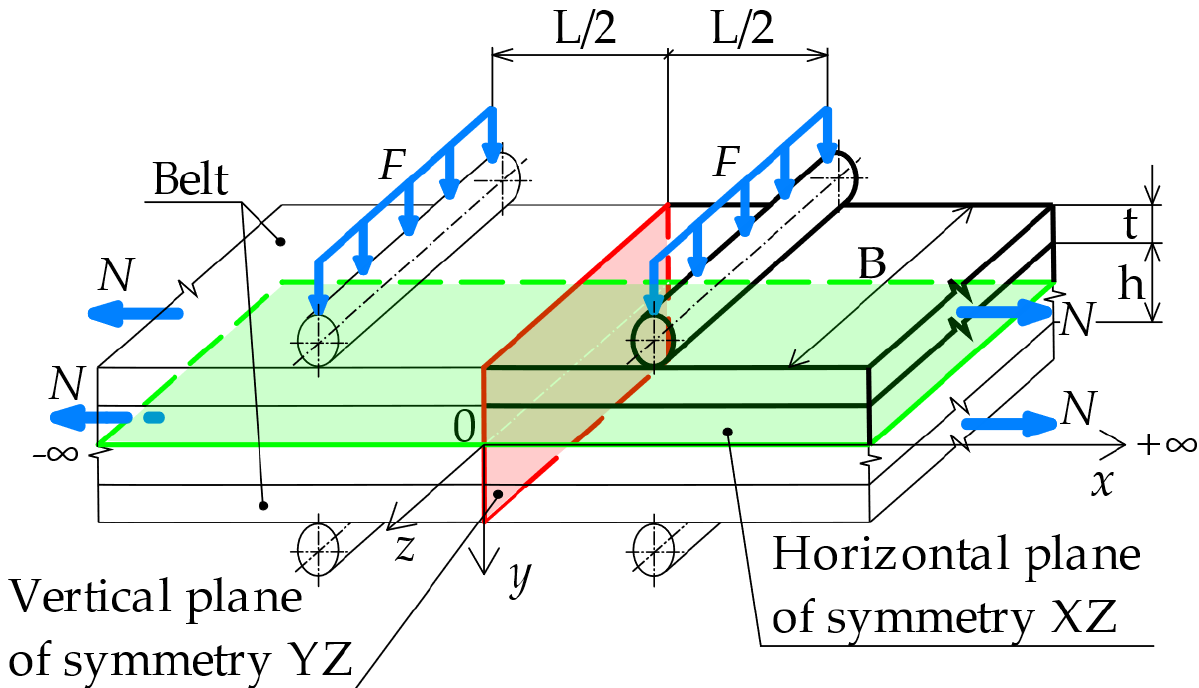
Figure 6. Diagram of loose material compression with marked symmetry planes.